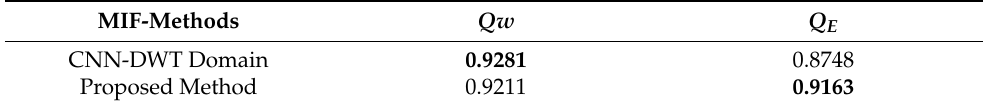
Figure 16. Multi-focus image of a flowerpot from various perspectives. Original Image: ( a ), Multi- focus Input Images: ( b , c ), and Proposed Fusion: ( d ). Table 10. The results and comparisons for flowerpot image